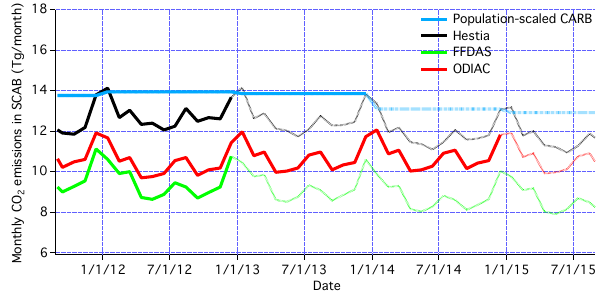
Figure 5. Time series of the different CO 2 monthly emissions (in unit of Tg per month) from the South Coast Air Basin. Emissions are color-coded as follows: population-scaled CARB in light blue, Hestia in solid black, ODIAC in solid red, and FFDAS in solid green. Extrapolated emissions using annual fuel consumption data are shown in faded solid